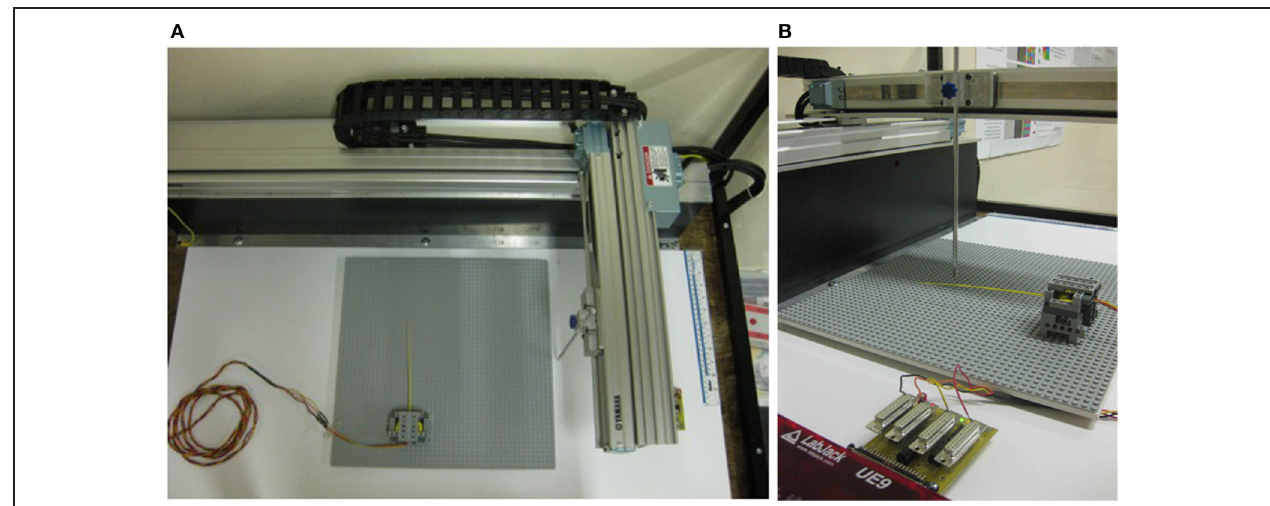
FIGURE 1 | The XY positioning robot. (A) From above, to show the range of movement available. (B) From the side. A narrow, rigid aluminium bar was moved into the whisker perpendicularly, from a clockwise or anticlockwise